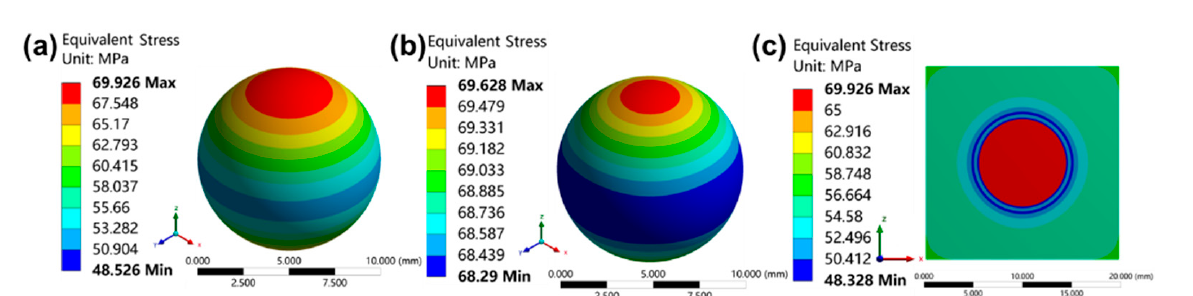
Figure 3. Contour diagrams of stress distributions in various parts of core–shell structure LWAC: ( a ) Shell; ( b ) Core; and ( c ) PATH I section.